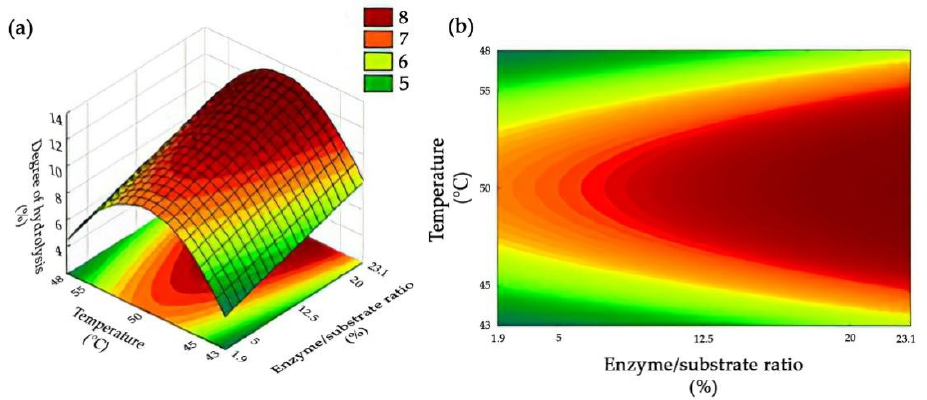
Figure 2. Response surface of enzymatic hydrolysis at 10 h. ( a ) Surface plot; ( b ) Counter plot.